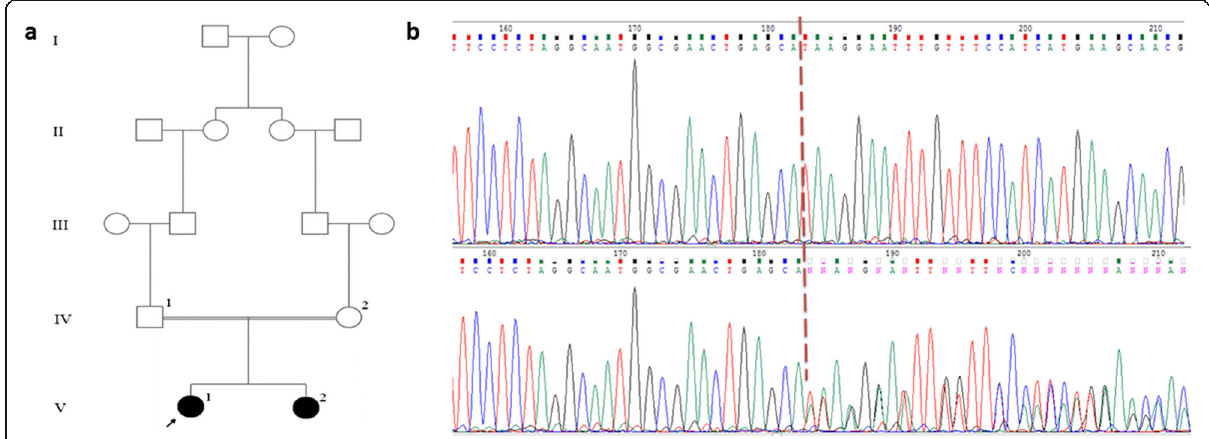
Fig. 1 a Pedigree of the family with two affected children (filled symbols). b Sequence chromatograms of c.1294_1295delA mutation in the affected proband V1 are shown in homozygous form (up) compared to heterozygous form (her mother (IV2) (down)). Site of the deletion is shown with